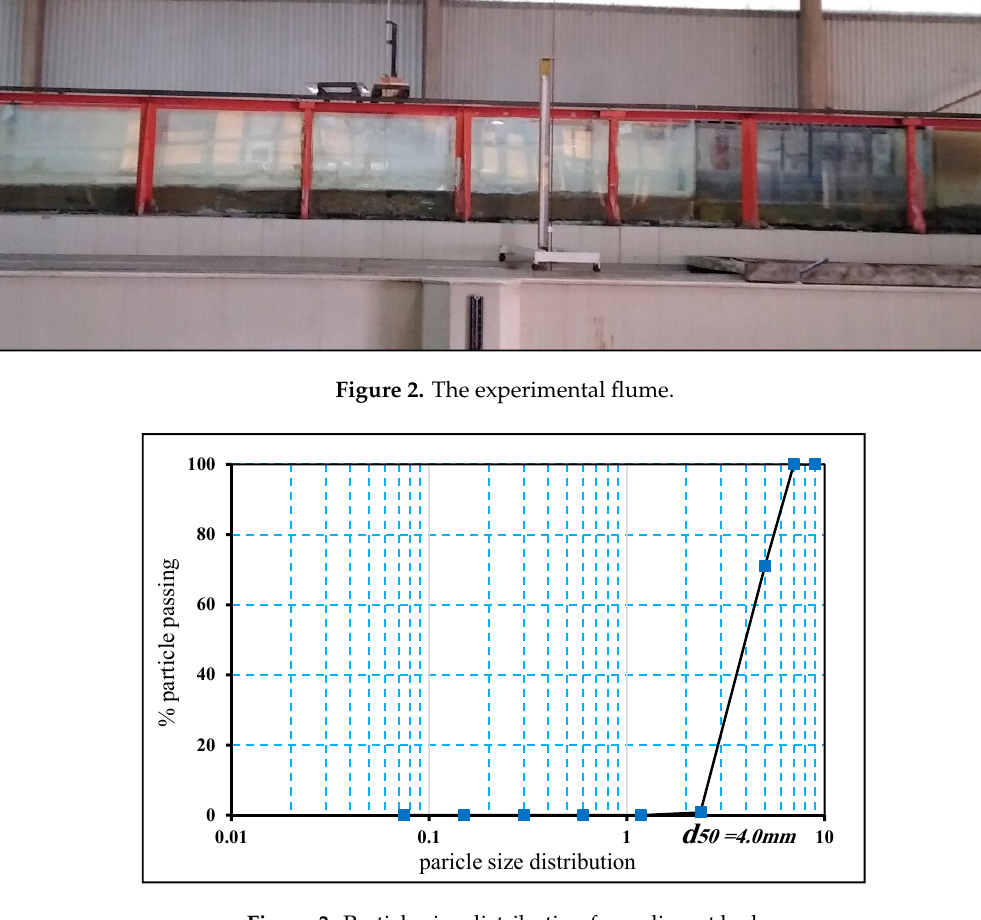
Figure 3. Particle size distribution for sediment bed. Table 1. Tested submergence and blockage ratios.